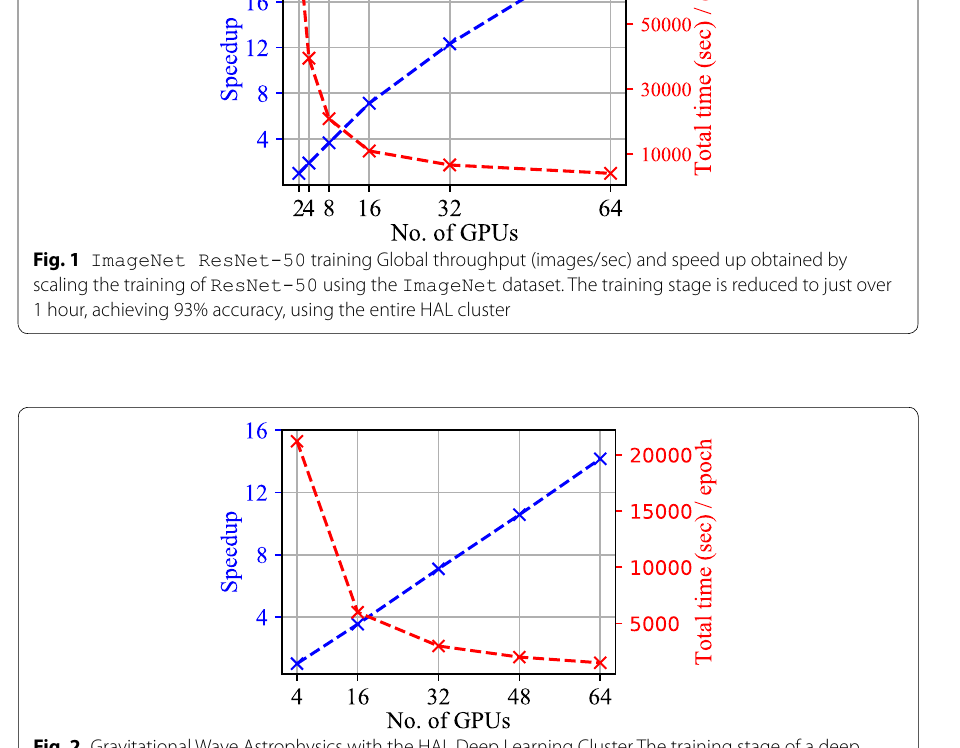
Fig. 2 Gravitational Wave Astrophysics with the HAL Deep Learning Cluster The training stage of a deep learning model, used to infer how rapidly two colliding black holes rotate, is reduced from 1 month—using a single V100 GPU—to 12.4 hours using the entire HAL deep learning cluster at the National Center for Supercomputing